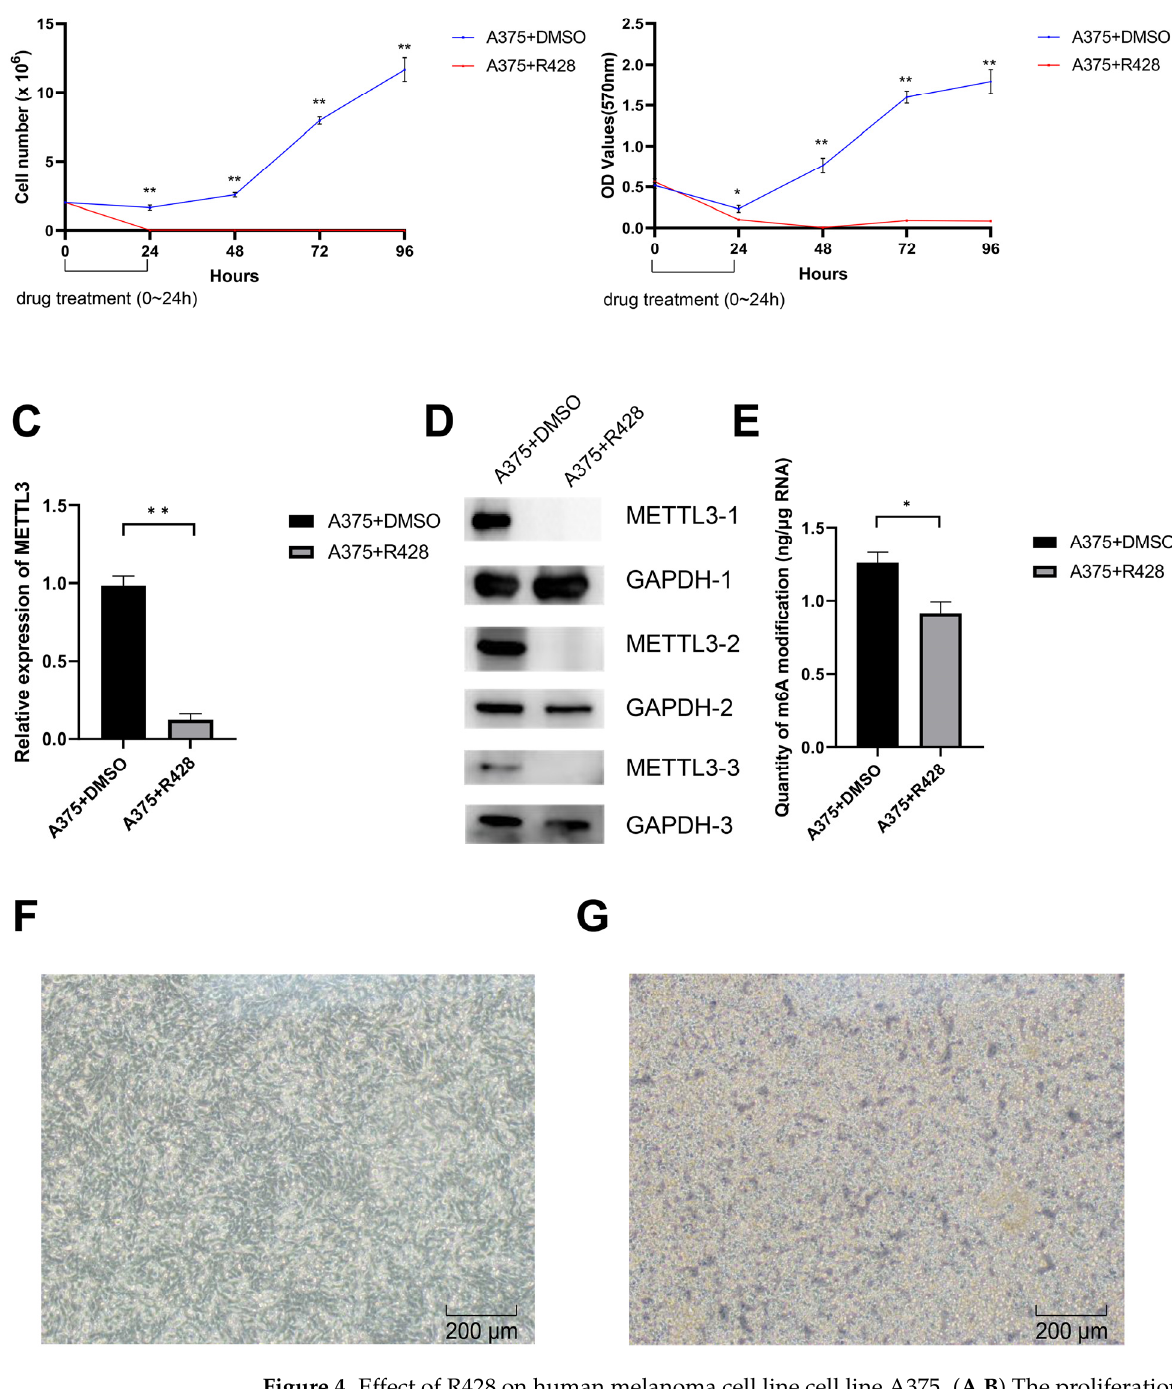
Figure 4. Effect of R428 on human melanoma cell line cell line A375. ( A , B ) The proliferation of the human breast cancer cell line A375 was significantly inhibited by R428 treatment. The results from the cell count assay ( A ) and the MTT assay ( B ) are shown. Data represented the mean ± SEM from five independent experiments, t -test, * p < 0.05, ** p < 0.01. Some SEM values in the drug-treated experimental group that are too small to be shown are specified here: ( A ) 24 h. 0.009; 48 h, 0.012; 72 h, 0.006; 96 h, 0.000; (B) 24 h. 0.004; 48 h, 0.002; 72 h, 0.006; 96 h, 0.002. ( C , D ) The protein expression of METTL3 in the A375 cell line was significantly reduced by drug treatment, t ‐ test, ** p < 0.01. The summary of Western blot grey values as the mean ± SEM from three independent experiments ( C ) and the representative Western blot result ( D ) are shown. ( E ) The RNA m6A modification level in the A375 cell line was significantly decreased after R428 treatment. Data represented the mean ±